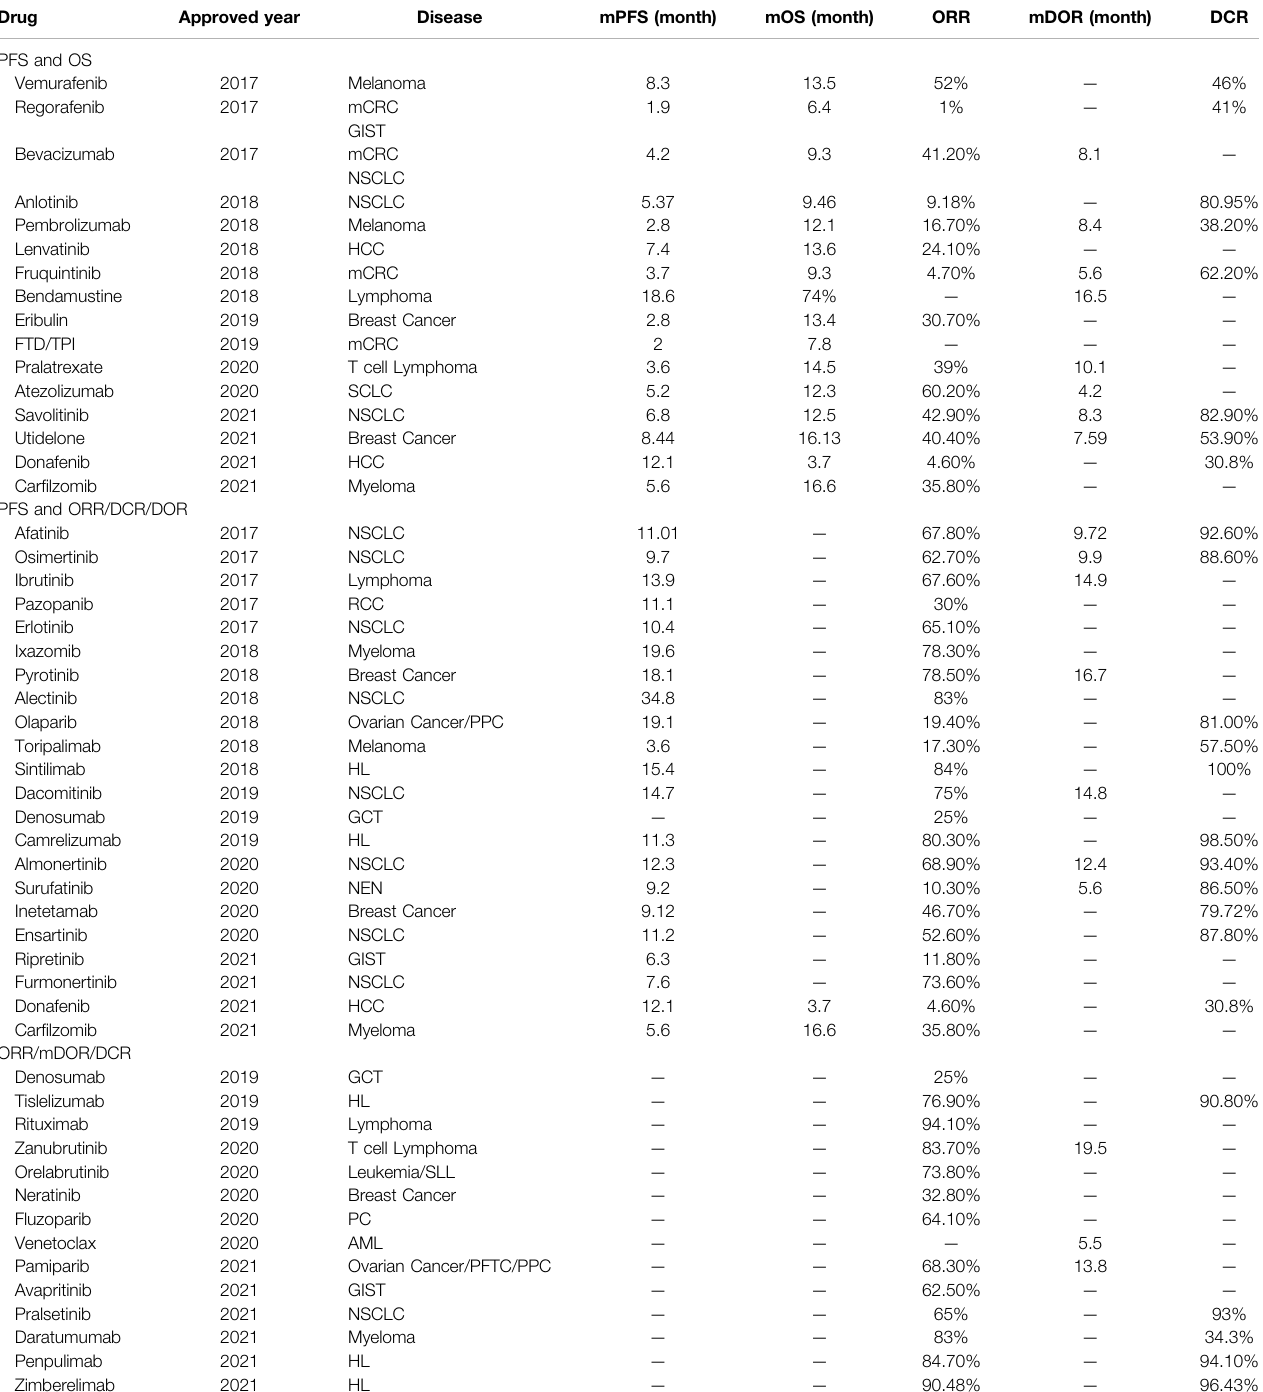
TABLE 1 | Summary of clinical endpoints of new anti-cancer drugs approved from January 2017 to November 2021. Drug